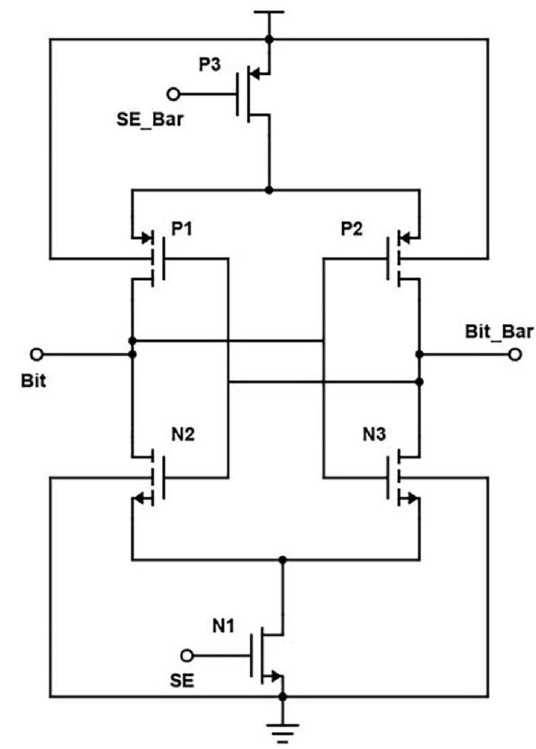
Figure 6. Basic Latched Sense Amplifier Schematic.